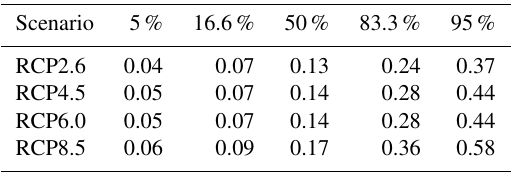
Table 11. Sea level contributions from basal ice shelf melting from Antarctica within the 21st century from all models for the different emission scenarios in metres.